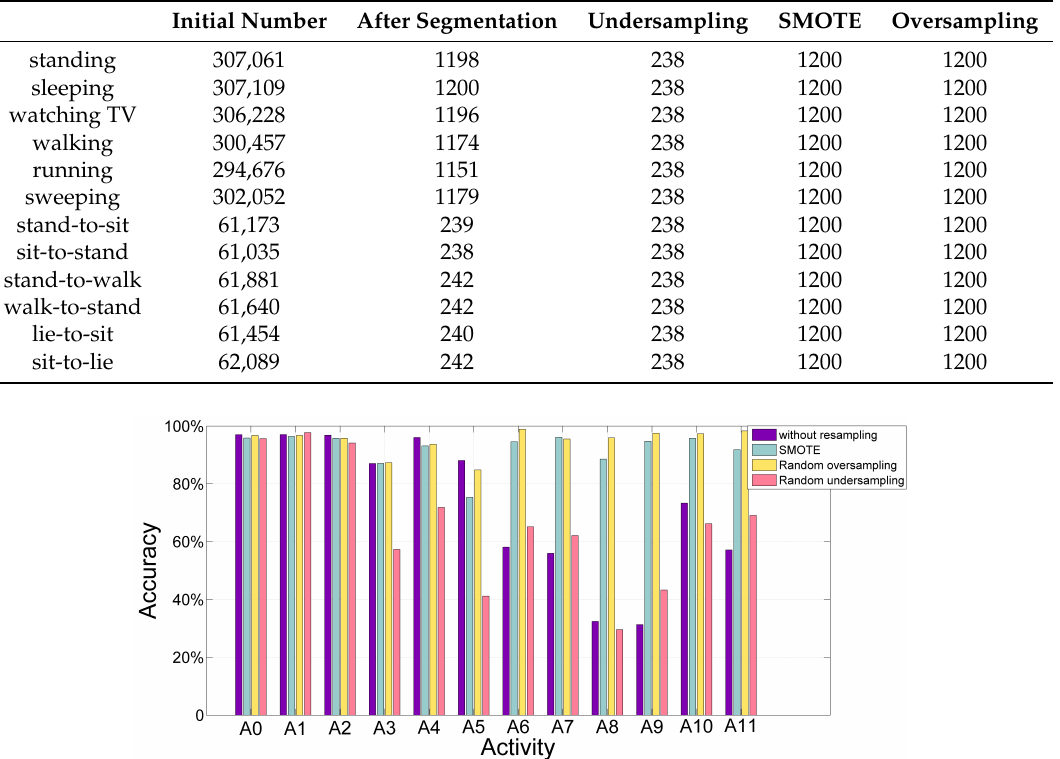
Table 4. The number of sample of raw data and the number of instance after segmentation and applying the resampling technique.